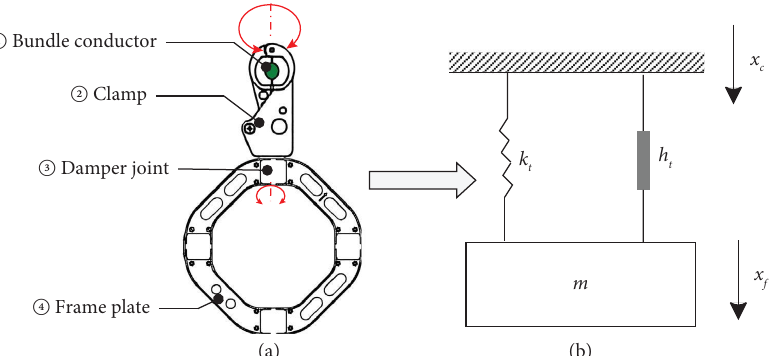
Figure 1: Schematic diagram of vibration transfer and vibration system equivalence model: (a) vibration transfer process and (b) vibration system equivalence